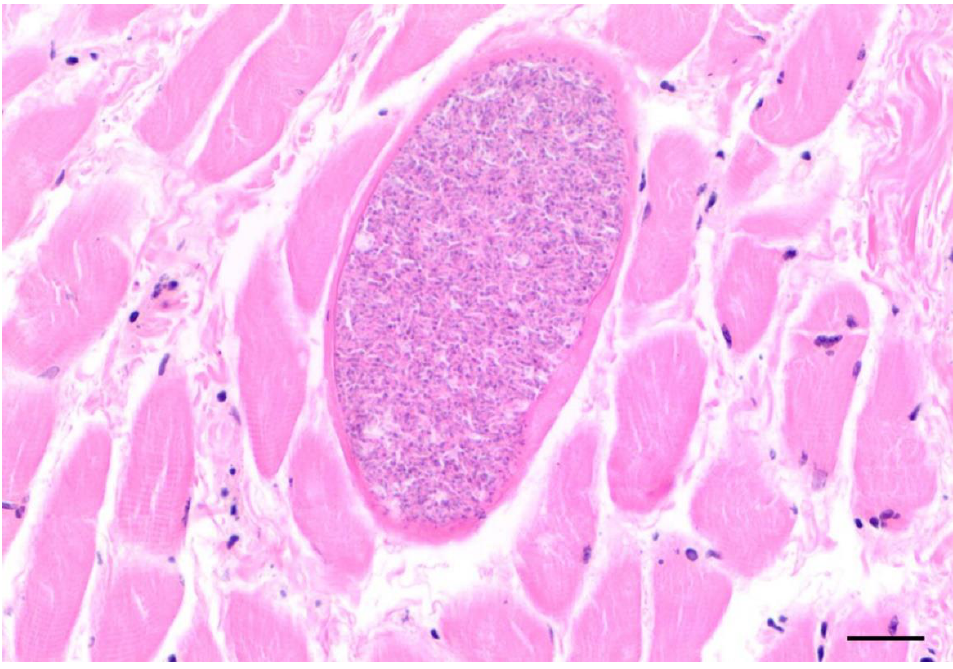
Figure 9. Cyst of Sarcocystis lutrae in the tongue of an otter from Schleswig-Holstein (scale bar 100 µ Serological testing of available haemolytic sera for anti- Toxoplasma gondii antibodies yielded positive results in both duplicate setups (each one for serum and meat juice) in seven out of nine otters, while the two other individuals were negative in all reactions.